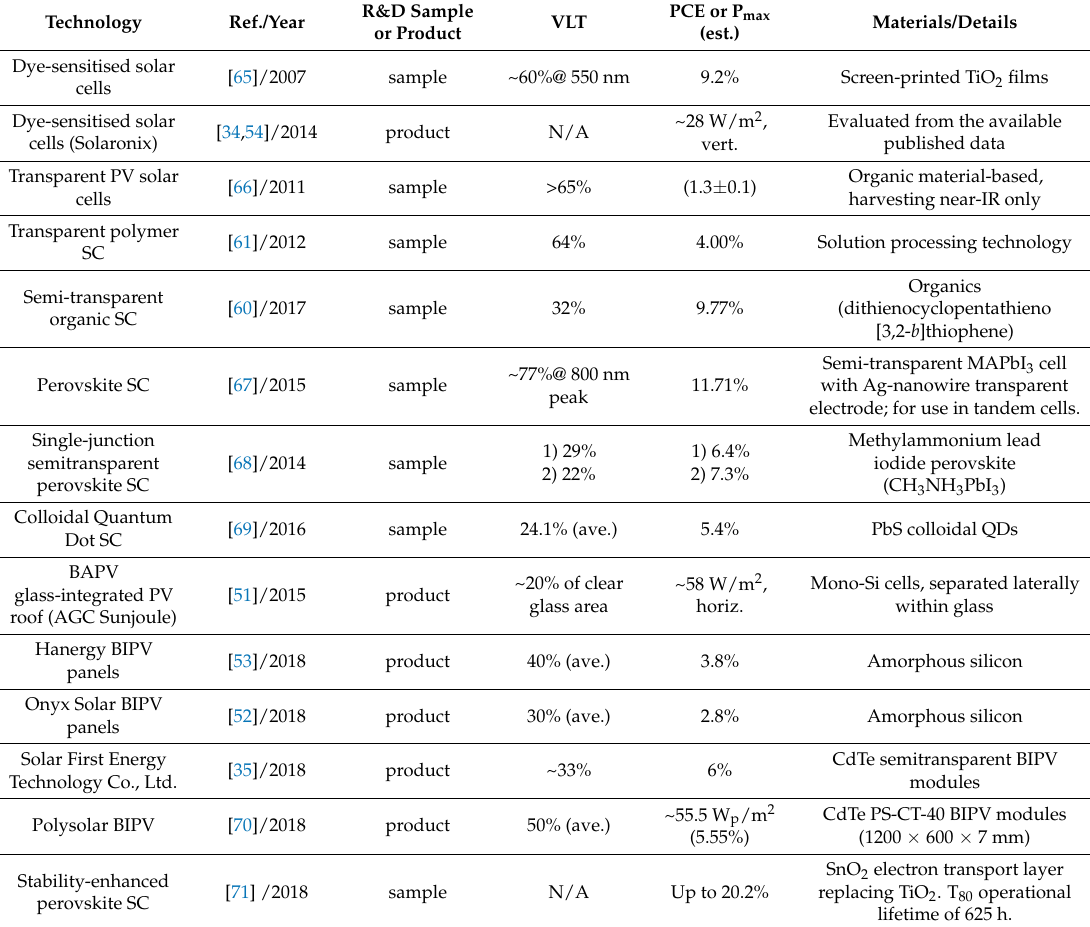
Table 1. Performance summary (transparency, materials, and efficiency-related data) for main non-concentrating semi-transparent solar cell technologies and building-integrated photovoltaics (BIPV) products with significant visible